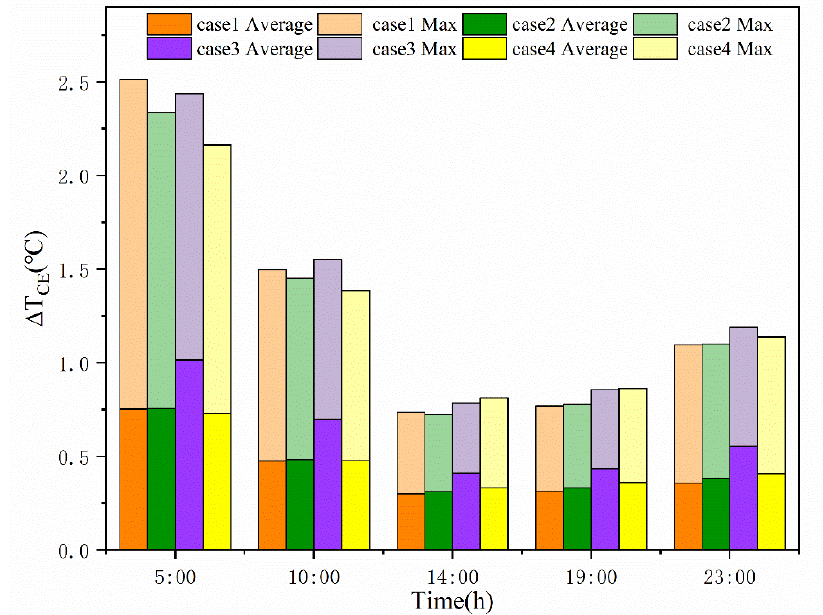
Figure 7. Average cooling effect and maximum cooling effect of cases 1, 2, 3 and 4.